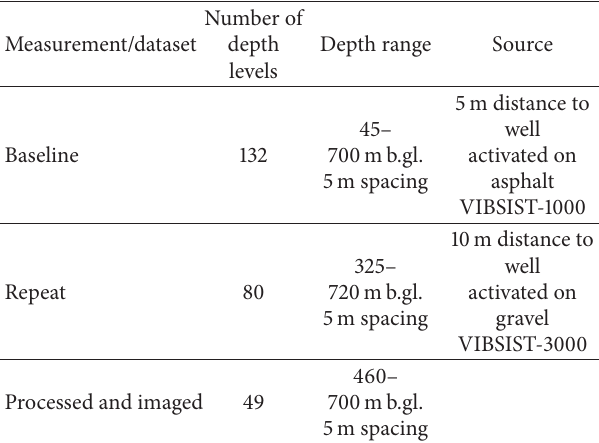
Table 2: Summary of source and receiver layout for the zero-offset VSP baseline and repeat measurements. The number of depth levels and the depth range used for processing and imaging are listed as well. The depth is in meter below ground level